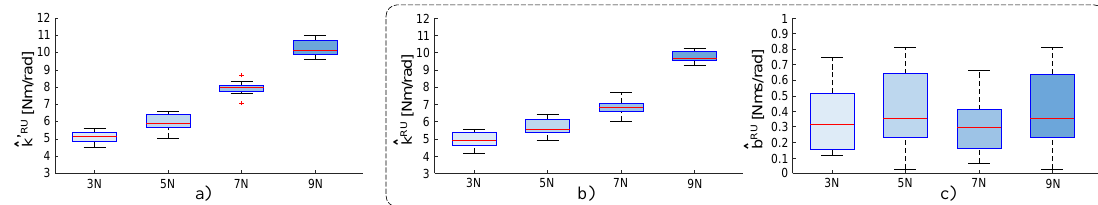
Figure 8. Estimation of wrist visco-elasticity during wrist-flexion-extension task.